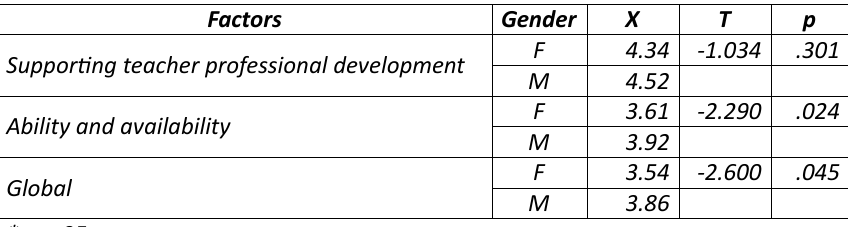
Table 2. Gender comparisons